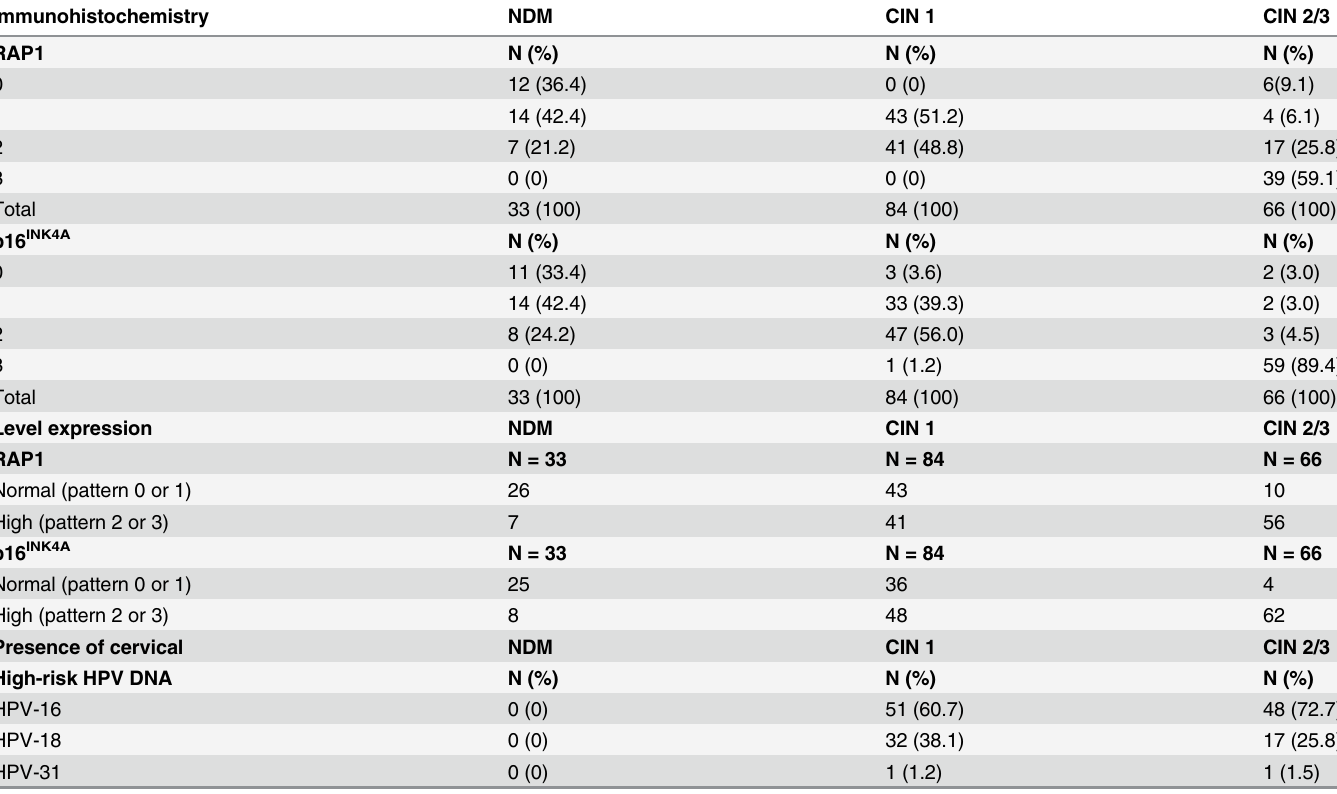
Table 1. Scores of RAP1 and p16 INK4A immunohistochemical expression in precursor lesions of cervical neoplasia.